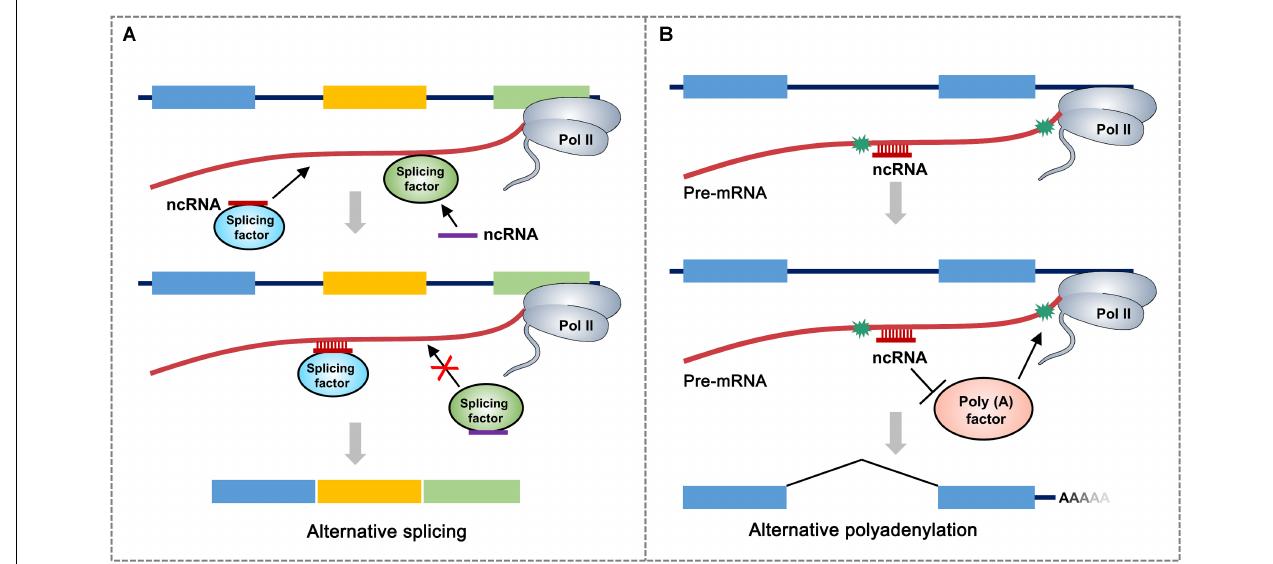
FIGURE 2 | A proposed model for non-coding RNA (ncRNA)-mediated regulation of alternative RNA processing. (A) ncRNA directly interacts with different splicing factor to influence alternative RNA processing through two possible mechanisms: ncRNA-splicing factor complex recognizes and binds to the junction region of intron and alternative exon to promote the retention of alternative exon. ncRNA can also inhibit the targeting of splicing factor to the splicing site of pre-mRNA. Asterisks represent polyadenylation signals. Rectangular boxes represent exons. (B) ncRNA recognizes and binds to polyadenylation signal-flanking sequence of pre-mRNA, which prevents the accession of polyadenylation-related factors, thereby leading to the usage of distal polyadenylation signal. Different colored boxes in (A) and (B) represent